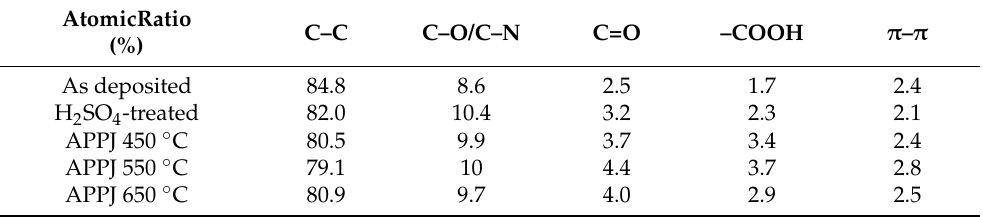
Table 1. Relative percentage of different groups in C 1 s